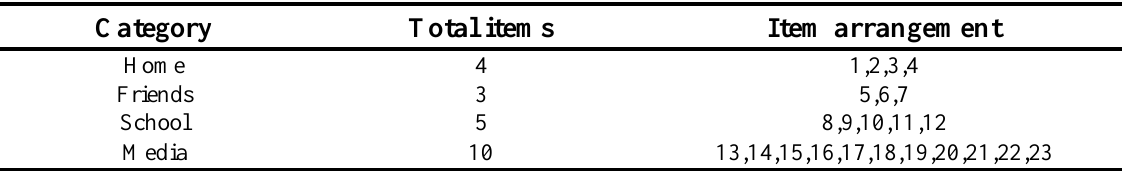
Table 2. Arrangement of